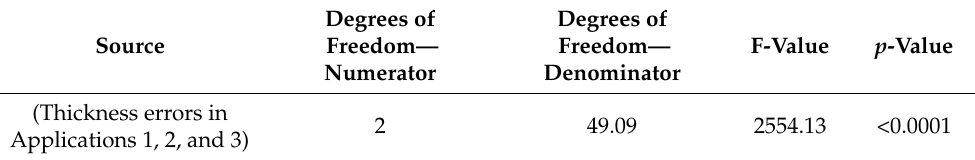
Table 6. The ANOVA results with the Welch’s test.